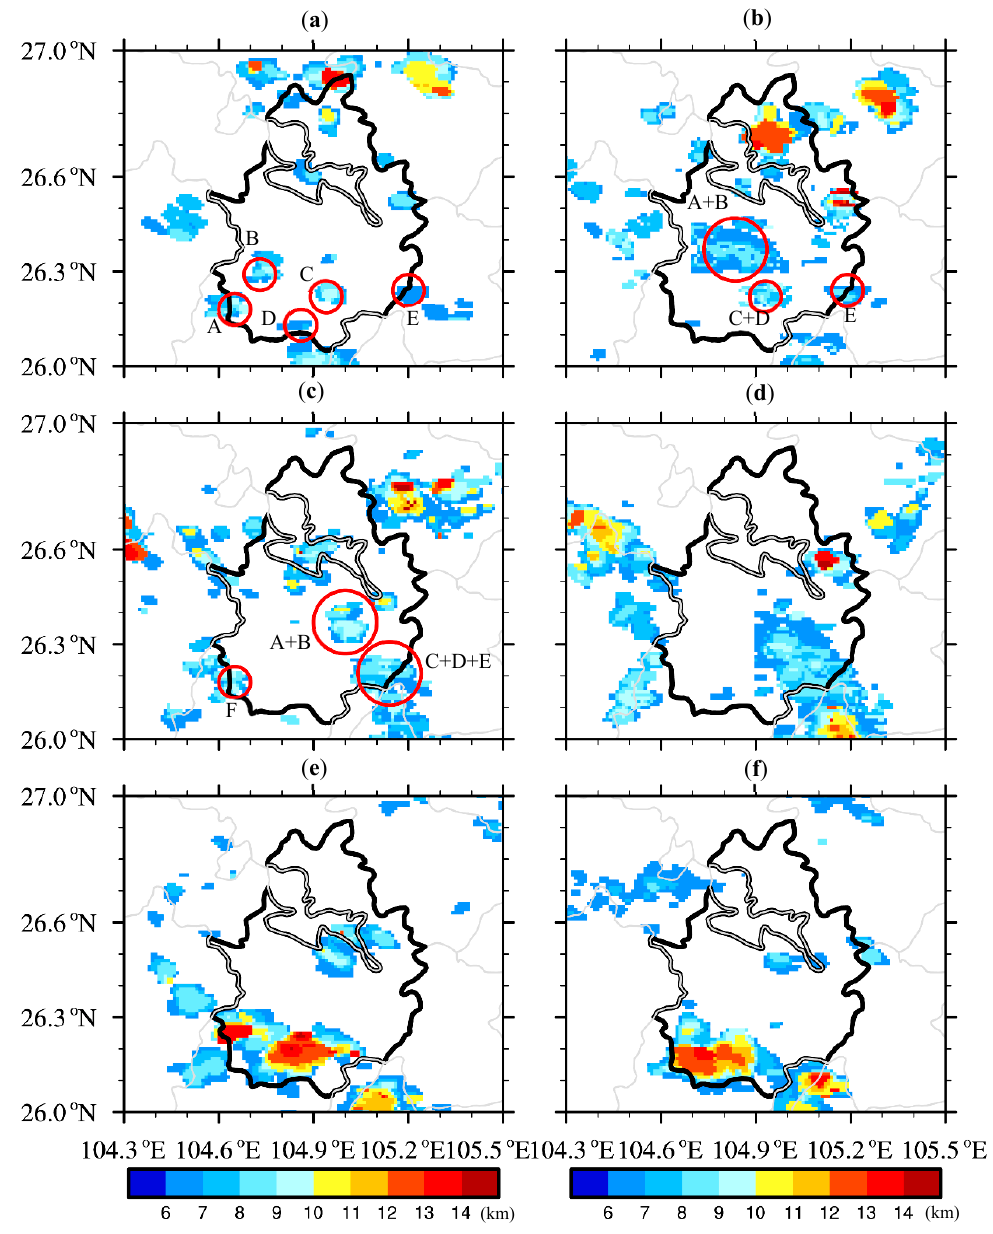
Figure 6. Radar maximum echo-top heights (shaded, km) of three-dimensional mosaic data near Shuicheng County ( a ) from 09:00 to 10:00 UTC; ( b ) from 10:00 to 11:00 UTC; ( c ) from 11:00 to 12:00 UTC; ( d ) from 12:00 to 13:00 UTC; ( e ) from 13:00 to 14:00 UTC; ( f ) from 14:00 to 15:00 UTC on 22 July 2019. The letters in the figure represent the convective cells referenced in the main text.